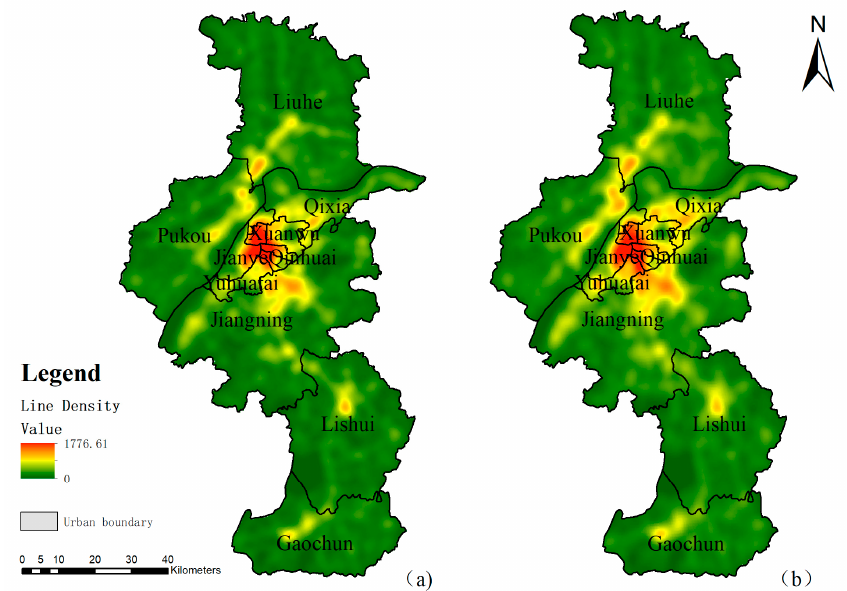
Figure 2. Line density of the road network in Nanjing. ( a ) Line density of road network in 2012; ( b ) Line density of road network in 2016.